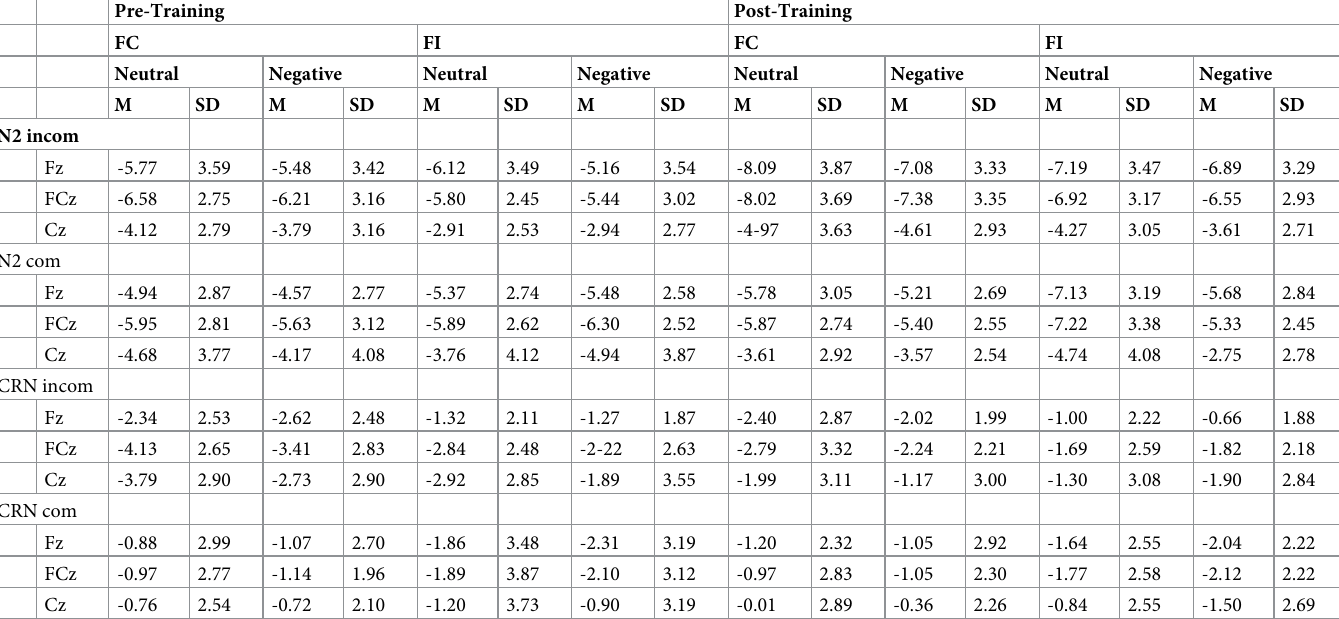
Table 3. Amplitudes (in μ V) of the N2 and CRN in compatible and incompatible trials after neutral and negative pictures in the FC and FI condition before and after training at electrode Fz, FCz and Cz.